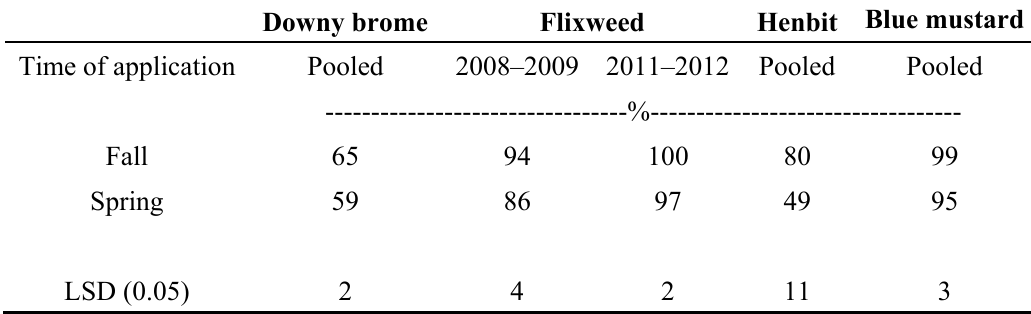
Table 4. Downy brome and broadleaf weed control in winter wheat as affected by time of application of herbicides averaged across herbicides, Hays, KS, 2008–2012.